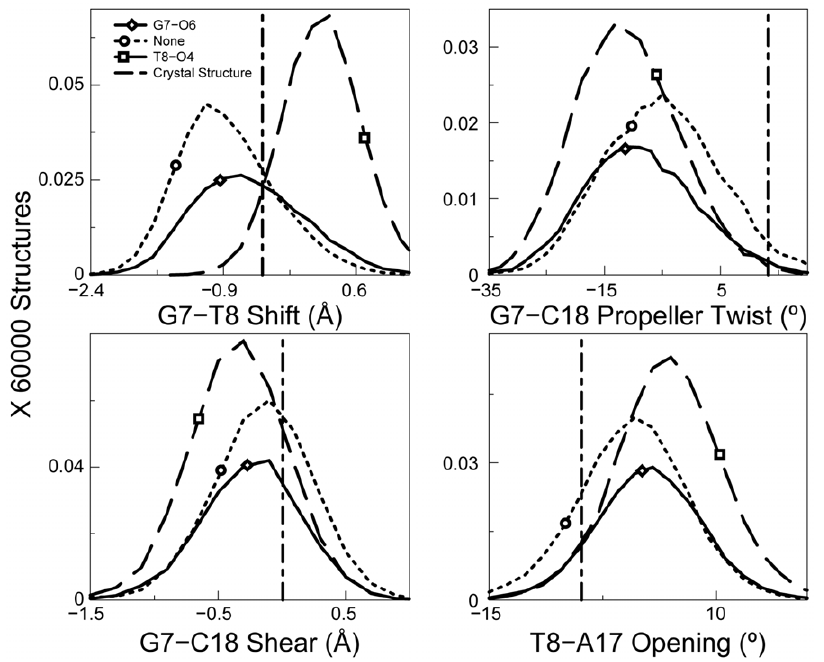
Figure 8. Helical parameters in the CP-TGGT sequence context. Four helical parameters plotted as a histogram for CP-TGGT. The most significant differences for different hydrogen bonded species of CP-DNA adduct are shown. The normalization was performed over the full 60000 structures to show the relative abundance of different hydrogen bonded species. The distribution for structures with no hydrogen bond formation is plotted in dotted lines, structures with G7-O6 hydrogen bond are designated by a solid line and structures containing a T8-O4 hydrogen bond are plotted in dashed line. The corresponding helical parameters for DNA in the crystal structure of CP-DNA bound to HMGB1a are plotted as a vertical dashed line.